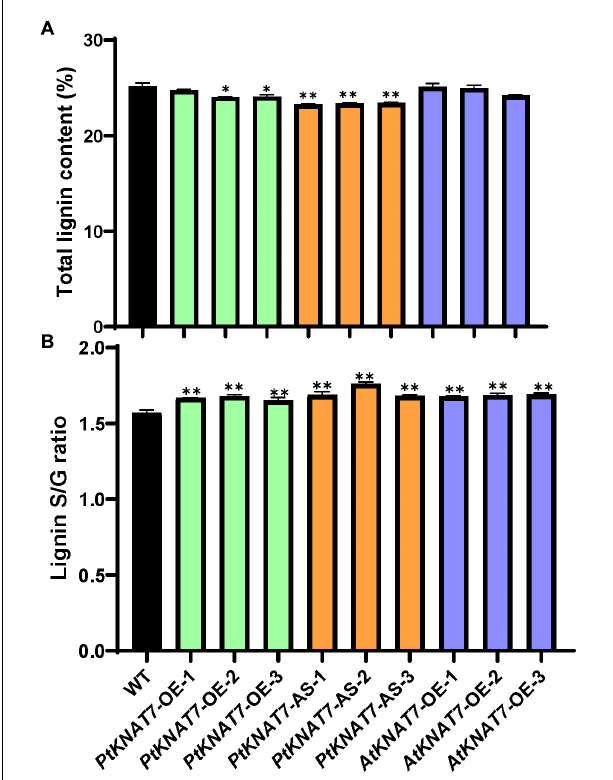
FIGURE 5 | Lignin content and S/G lignin ratio measurements in poplar transgenic lines: (A) Lignin contents in three PtKNAT7-OE, PtKNAT7-AS, and AtKNAT7-OE transgenic lines in poplar. (B) S/G lignin ratio measurements in three PtKNAT7-OE, PtKNAT7-AS, and AtKNAT7-OE transgenic lines in poplar. Data analyses were performed in duplicate for each sample. Significant observations are marked by * when compared to WT controls ( P -value <